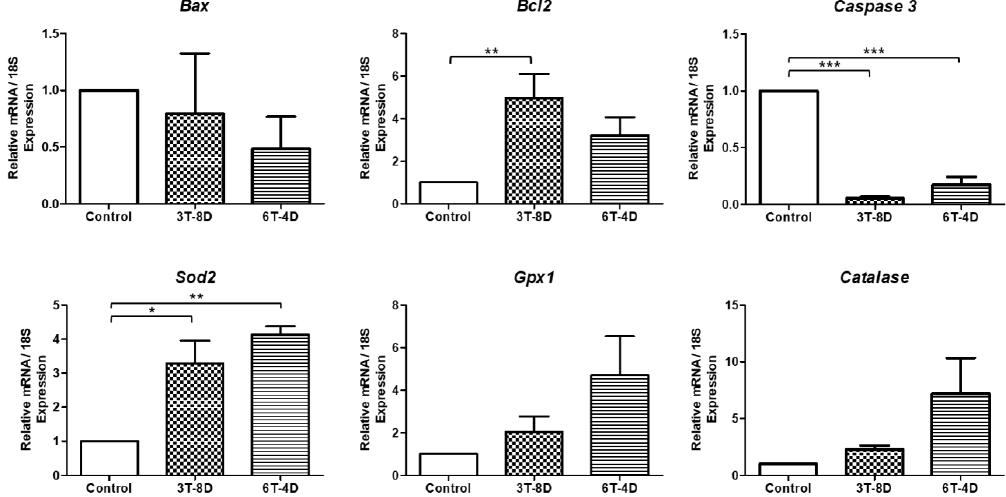
Figure 7. Relative expression to 18S of apoptosis and oxidative stress-related genes from the uterus of control and groups of human adipose-derived stem cell conditioned medium (ASC-CM) intravenous injection to 4-month-old ICR mice. Data are expressed as the mean ± standard error of the mean (SEM). * p < 0.05, ** p < 0.01, *** p < 0.001. 4D-6T, six times injection in four day intervals; 8D-3T, three times injection in eight day intervals.